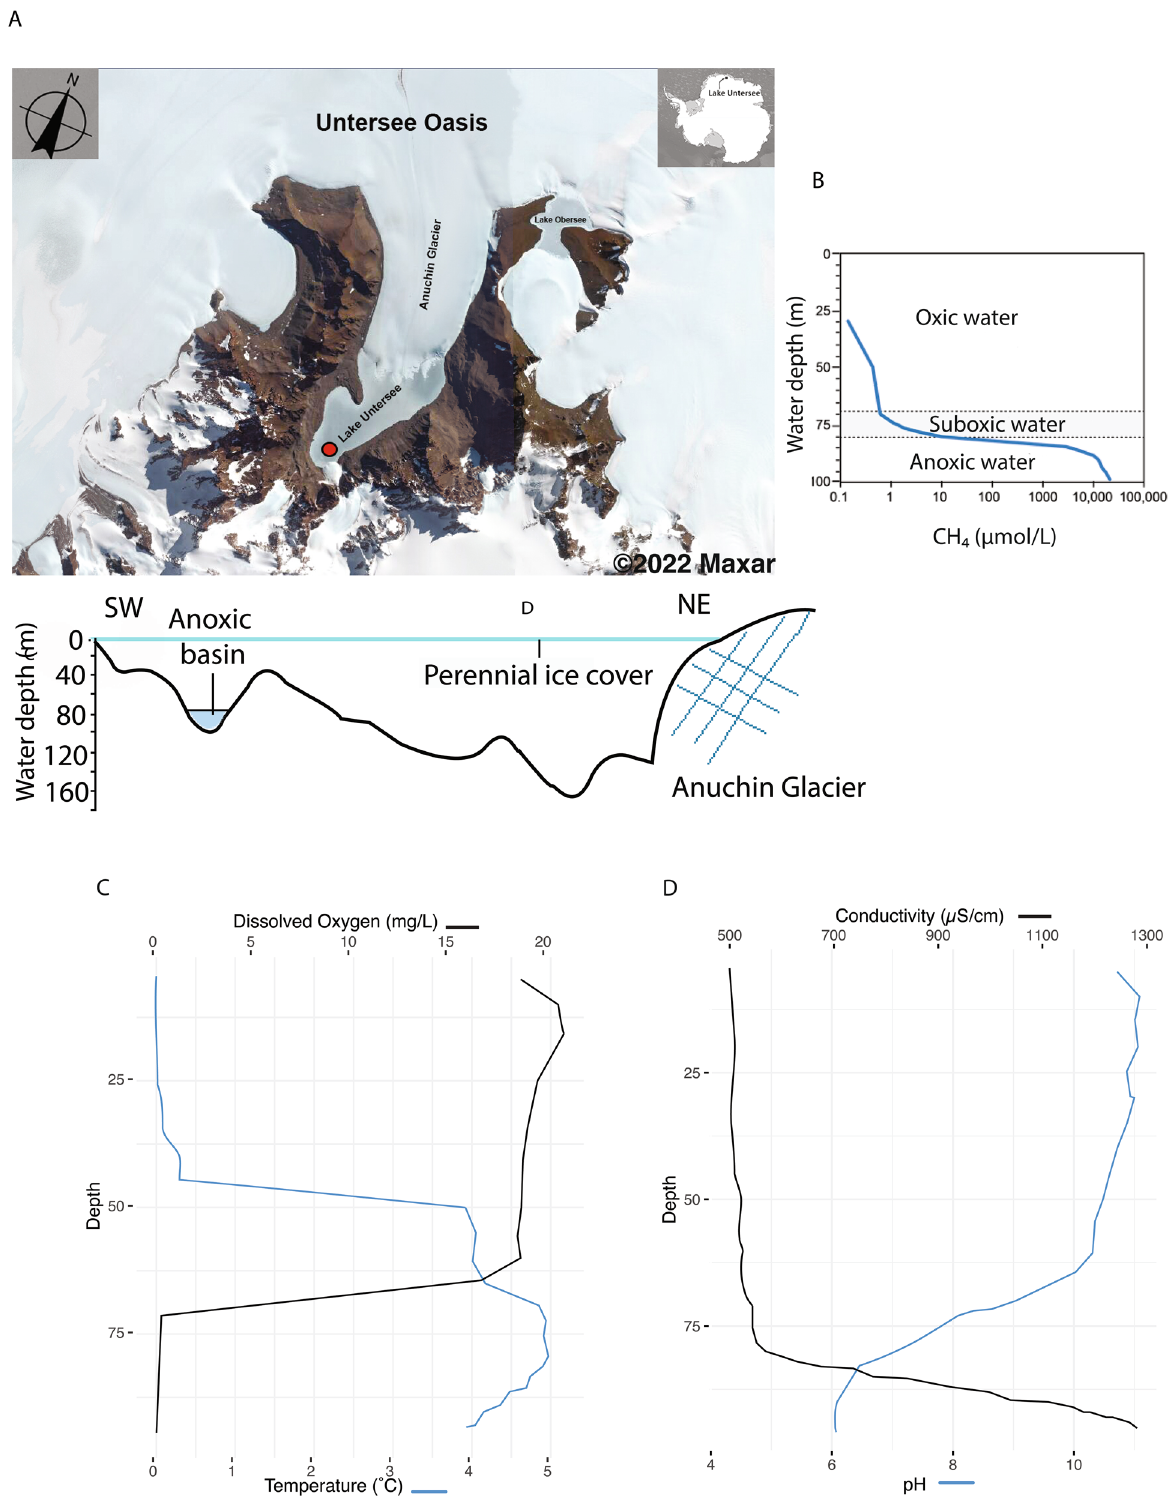
Figure 1. An Overview of Lake Untersee’s Anoxic Basin. ( A ) Satellite view of Lake Untersee and a cross-section of the bathymetry of the lake with the location of the anoxic trough in the South basin. ( B ) Dissolved methane concentrations within the South basin. ( C ) Dissolved oxygen concentrations and temperature within the South basin. ( D ) pH and conductivity in the South basin. Image credit: satellite imagery (©Maxar) provided by NextView License, depth profiles modified from Wand et al., 2006 and Dale Andersen, unpublished